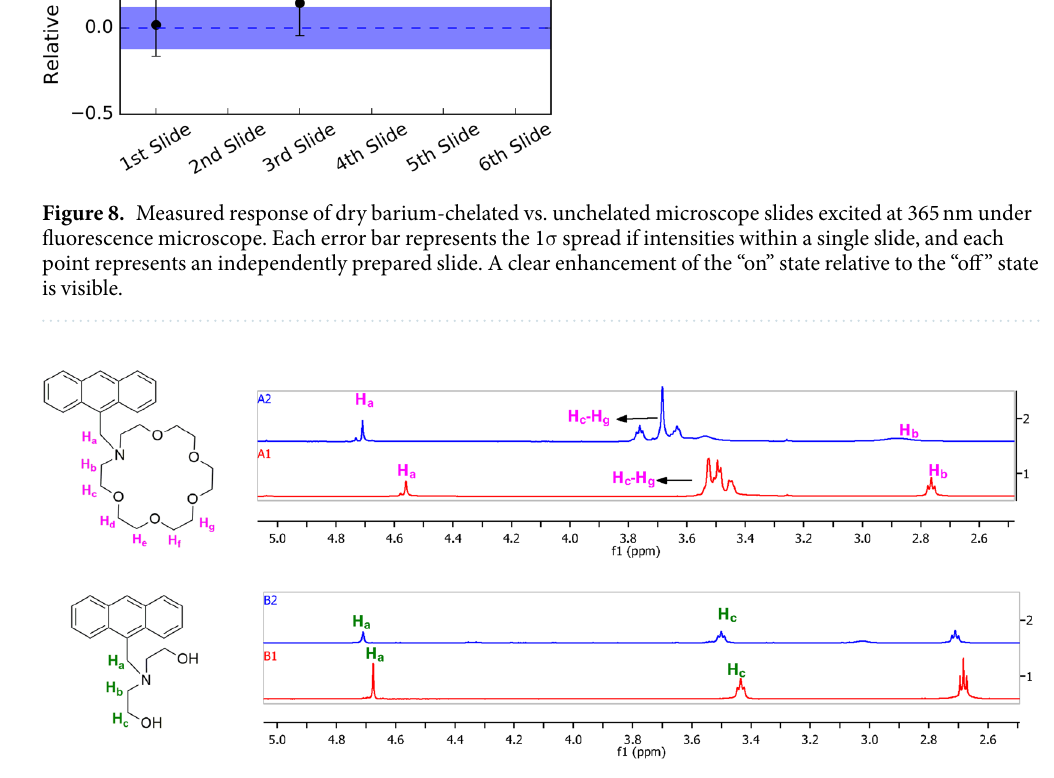
Figure 9. NMR experiment showing barium binding in 18c6-an and lin-an. Bottom (red) traces show fluorophore without barium, and top (blue) traces show fluorophore with barium in 1:1 ratio. Lone pairs are coordinated to barium, leading to decrease in electron shielding around the proton labelled as H a in the 18c6 receptor. The similar proton shows much smaller shift in the lin receptor, which does not have a strong tendency to bind